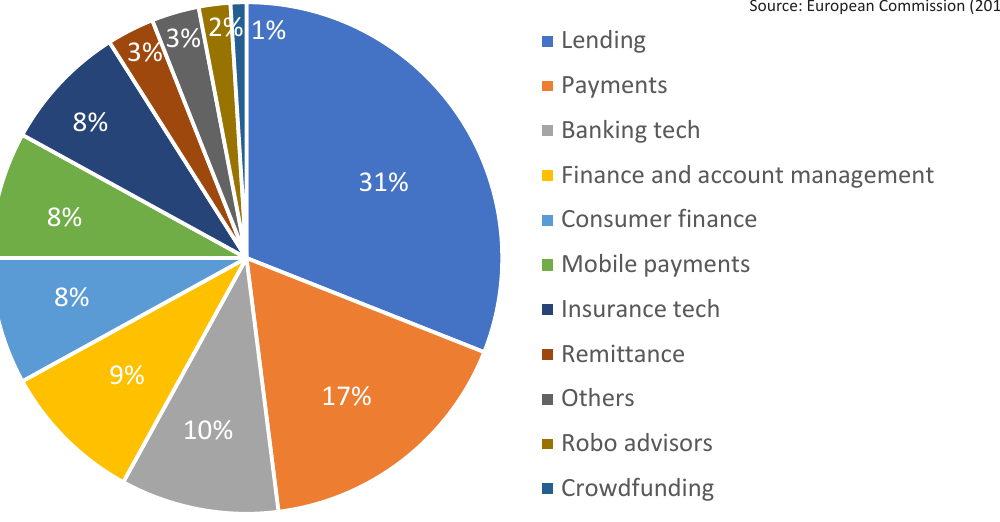
Figure 4. Global funding invested in FinTech platforms in 2016, %